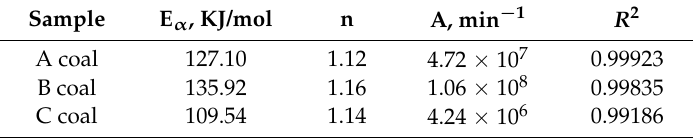
Figure 3. Combustion kinetics profiles of A coal, B coal, and C coal. Table 3. Kinetic parameters calculated by Freeman–Carroll method.